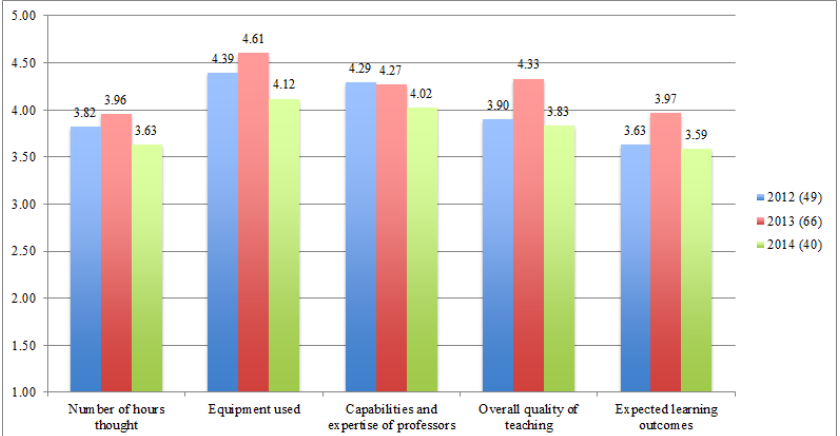
Figure 9. Mean rating of how satisfied participants were with the academic and pedagogical aspects of the